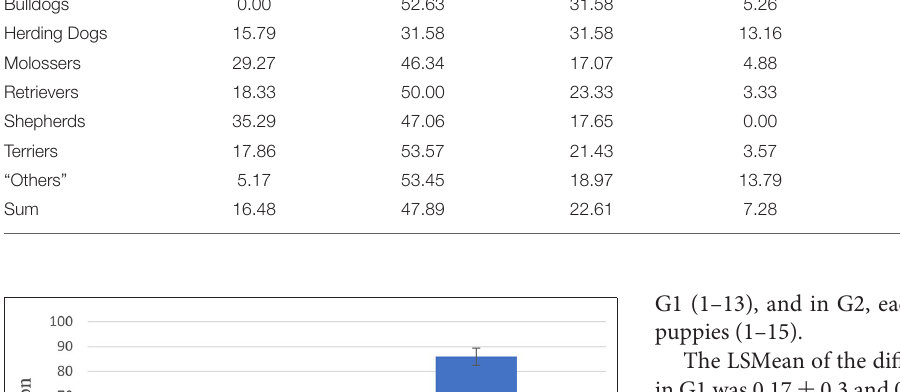
TABLE 2 | Distribution (%) of mated bitches depending on the used heat number and the breed group after a previous parturition. Breed group